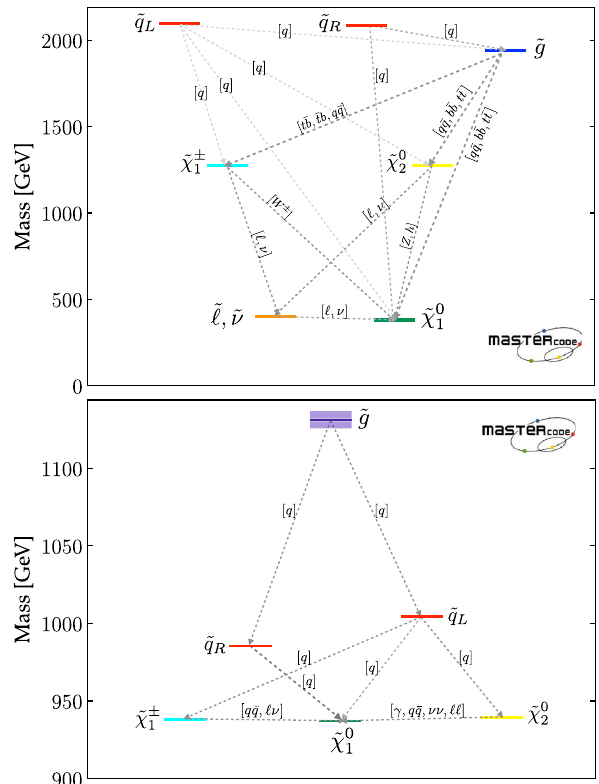
Fig. 3 Upper panel: The dominant sparticle decay chains at the repre- sentative point in the ‘nose’ region in the top left panel of Fig. 2 (with ( g − 2 ) μ ) whose parameters are listed in the second column of Table 4. Lower panel: The dominant sparticle decay chains at the representa- tive point in the ‘nose’ region in the top right panel of Fig. 2 (without ( g − 2 ) μ ) whose parameters are listed in the fourth column of Table 4 – notethattheverticalscalehasasuppressedzero.Inbothplotsthewidths of the sparticles are represented as semi-transparent bands around